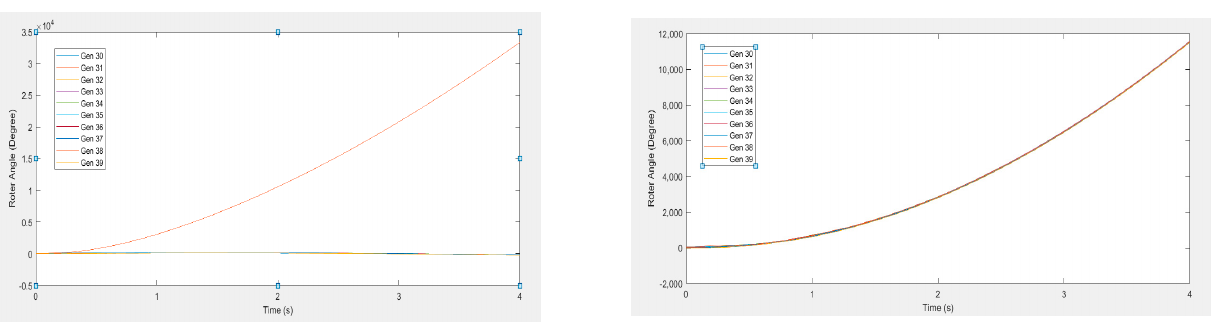
Figure 6. Comparison of rotor angle curve before and after collaborative transient stability control on fault lines 26 − 29 of IEEE 39 bus system.